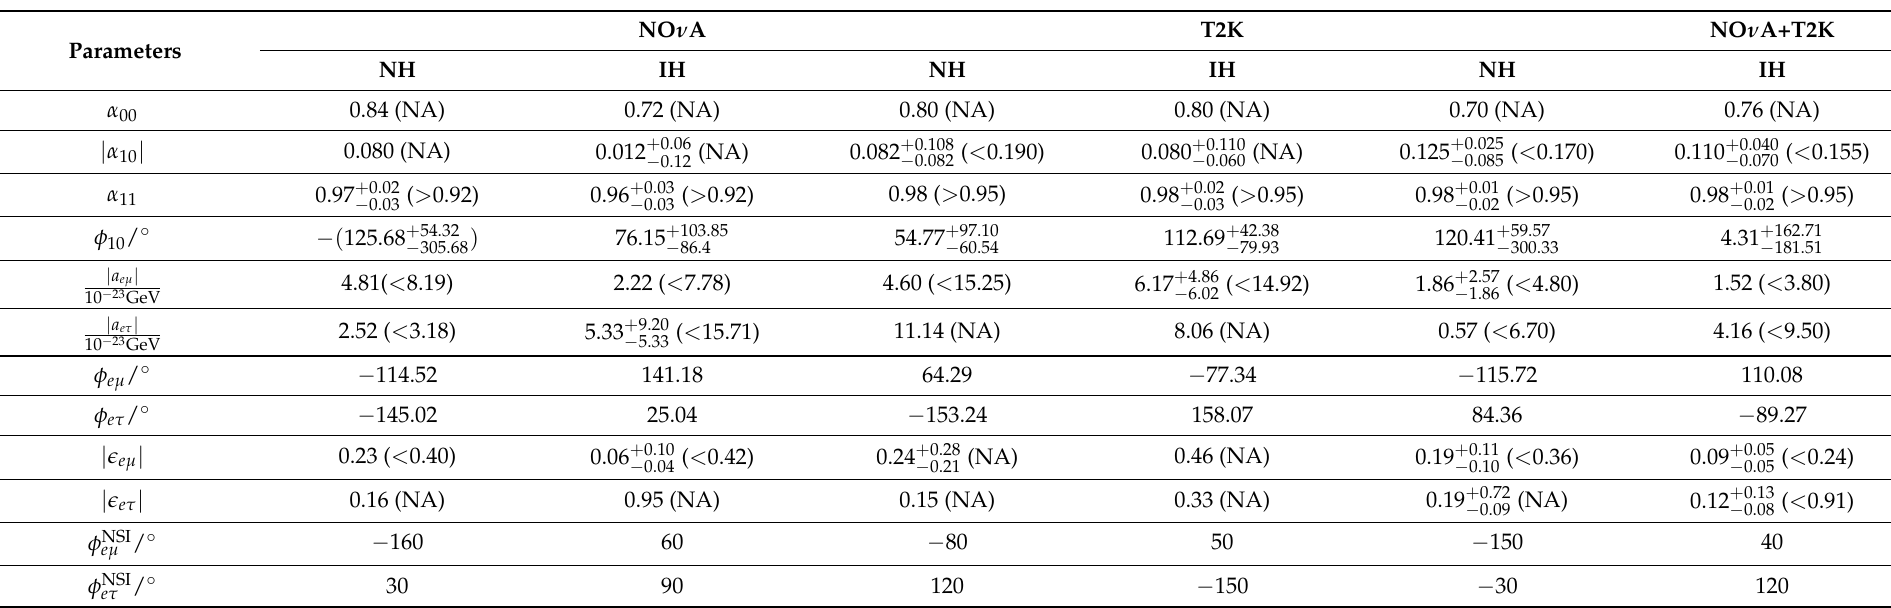
Table 7. Best-fit values of several BSM parameters discussed in Section 5 along with the 1 σ -error bar, where available. The 90% C.L. limits for 1 d.o.f. have